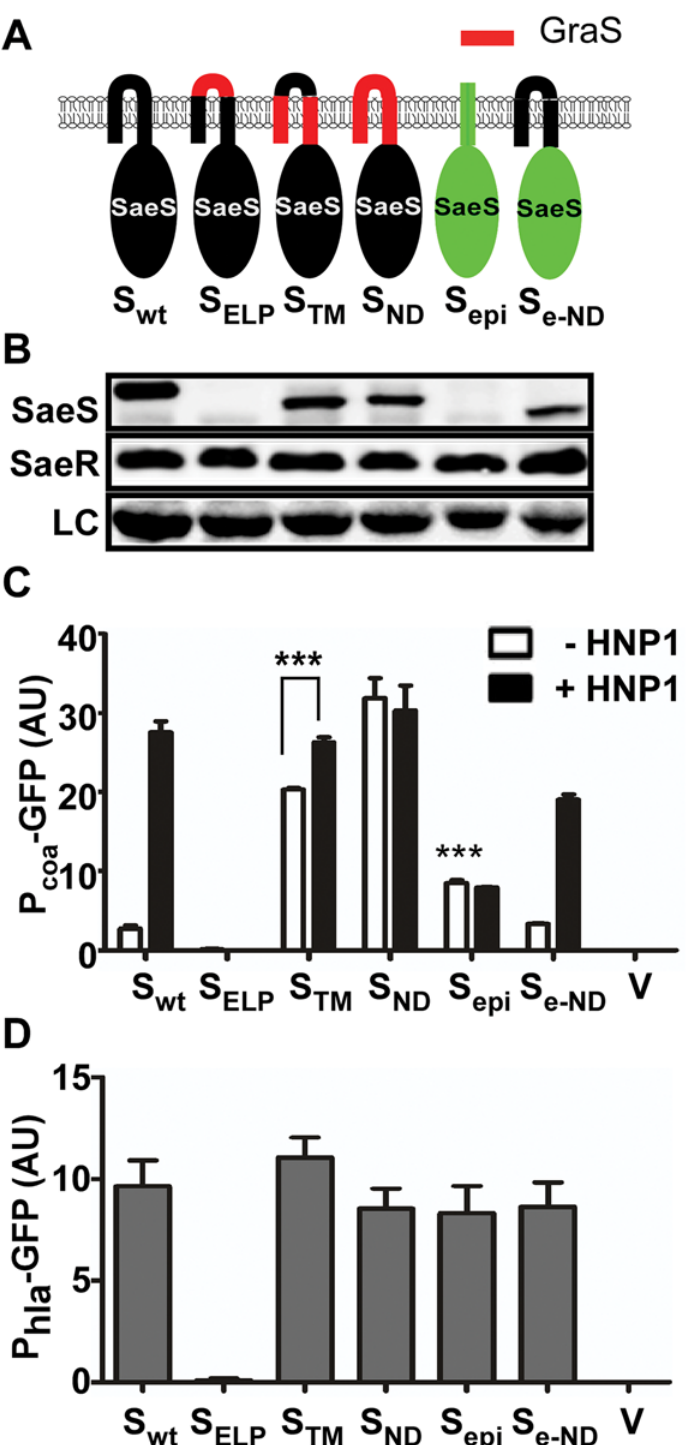
Fig 2. The N-terminal domain of SaeS controls the basal expression level and response to HNP1. (A) A diagram for the hybrid SaeS mutants. SaeS sequence is indicated in black while the sequence of GraS, an intramembrane sensing kinase in S . aureus , is in red. The sequence of S . epidermidis SaeS is shown in green. wt, wild type; ELP, extracytoplasmic linker peptide; TM, transmembrane helices; ND, N-terminal domain; epi, S . epidermidis ; e-ND, S . epidermidis SaeS with S . aureus N-terminal domain. (B) Expression